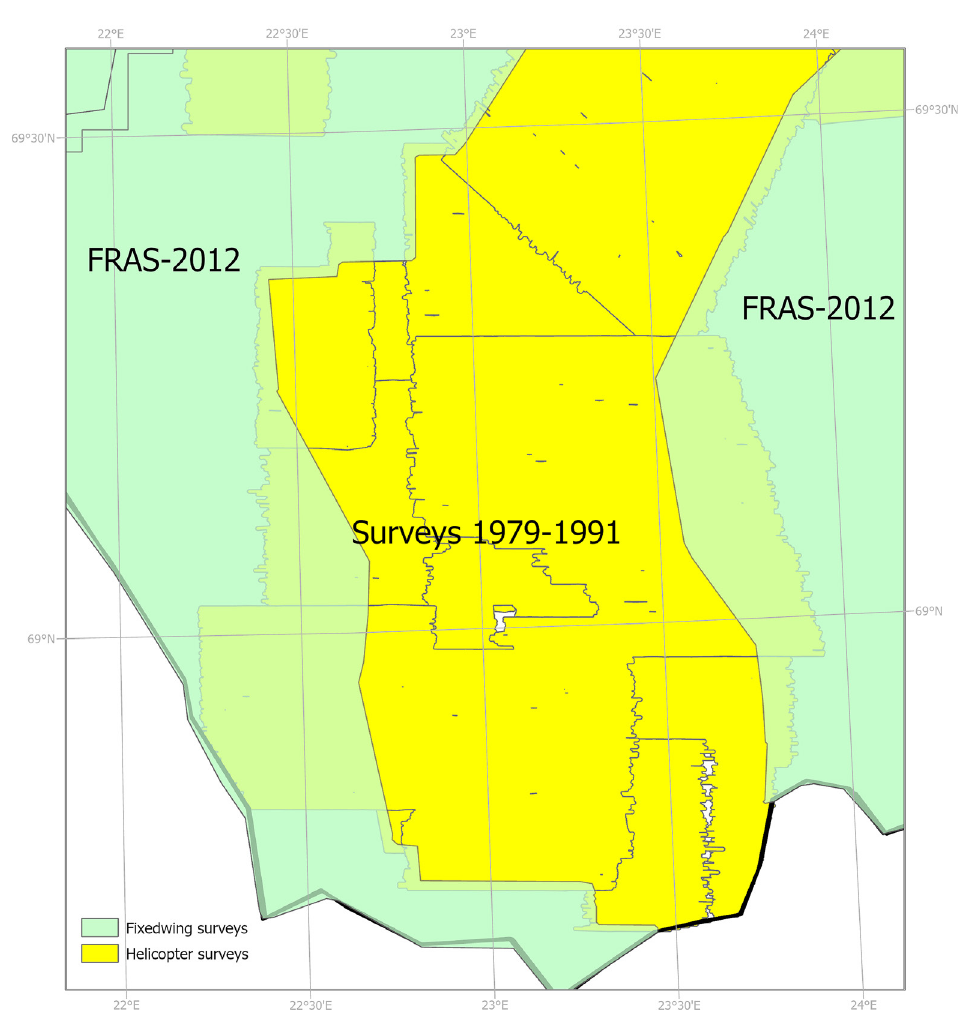
Figure 6. The location of the radiometric surveys outlined by the coloured polygons. More details can be found in Nasuti et al.